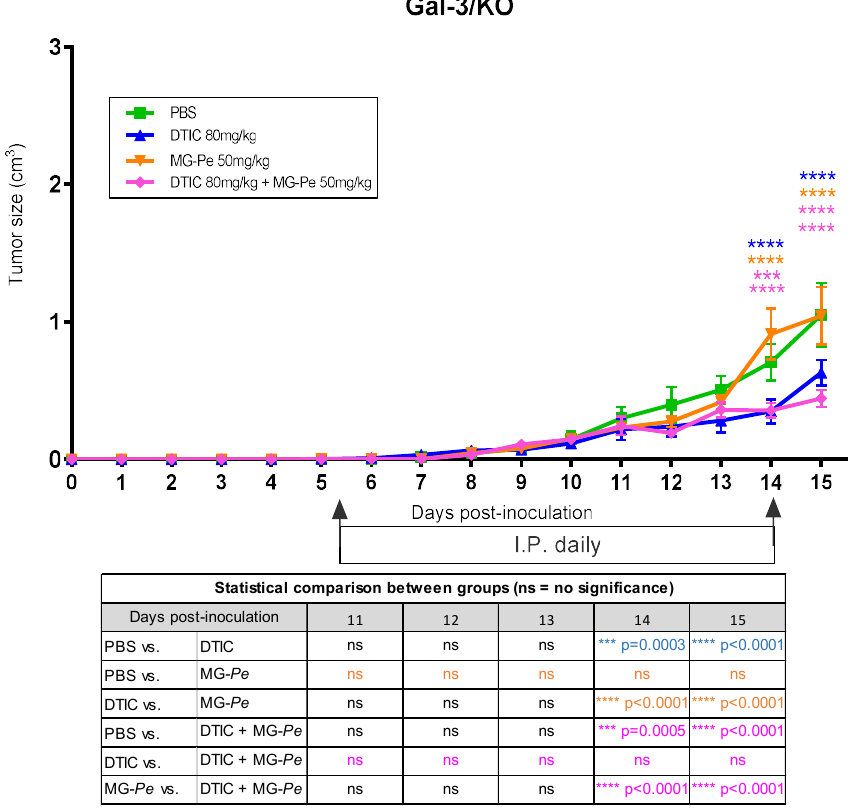
Figure 4. Tumor evolution with the influence of Gal-3. To investigate Gal-3 influence on MG- Pe antitumoral effect C57BL/6 Gal-3 knockout mice (Gal-3/KO) were used. Mice were inoculated with B16-F10 cells on the right dorsal flank, and subsequent treatment with PBS (control), dacarbazine (DTIC) (80 mg/kg), MG- Pe (50 mg/kg), or the combination of DTIC+MG- Pe (80 + 50 mg/kg). The data were submitted to a two-way ANOVA test with Tukey’s post-test with multiple comparisons (mean/SEM) ( n = 5 in each group).